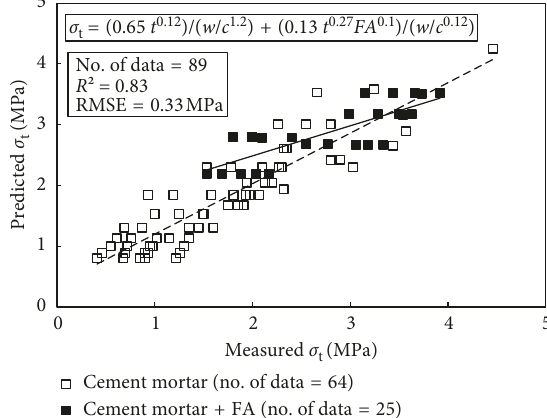
Figure 10: Relationship between measured and predicted split tensile strengths for cement mortar with and without fly ash Table 3. Good relationships were observed between measured and predicted flexural strengths ( σ in Figure 11: